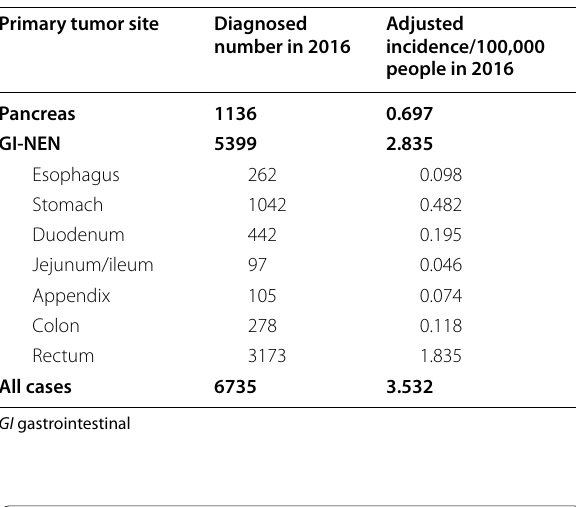
Table 1 Incidence of NEN in Japan in 2016 [3]